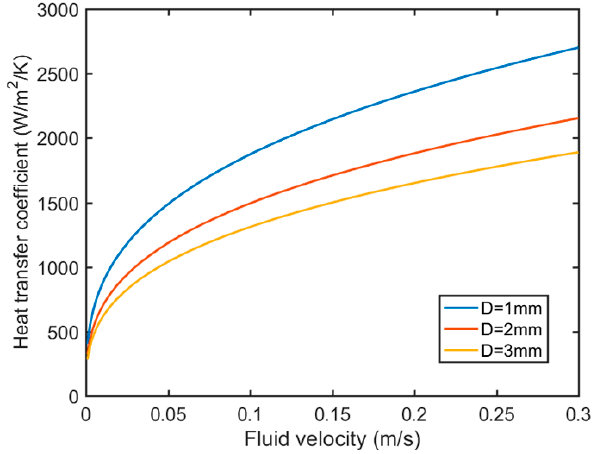
Figure 17. Heat transfer coefficient as a function of fluid thickness and fluid velocity.